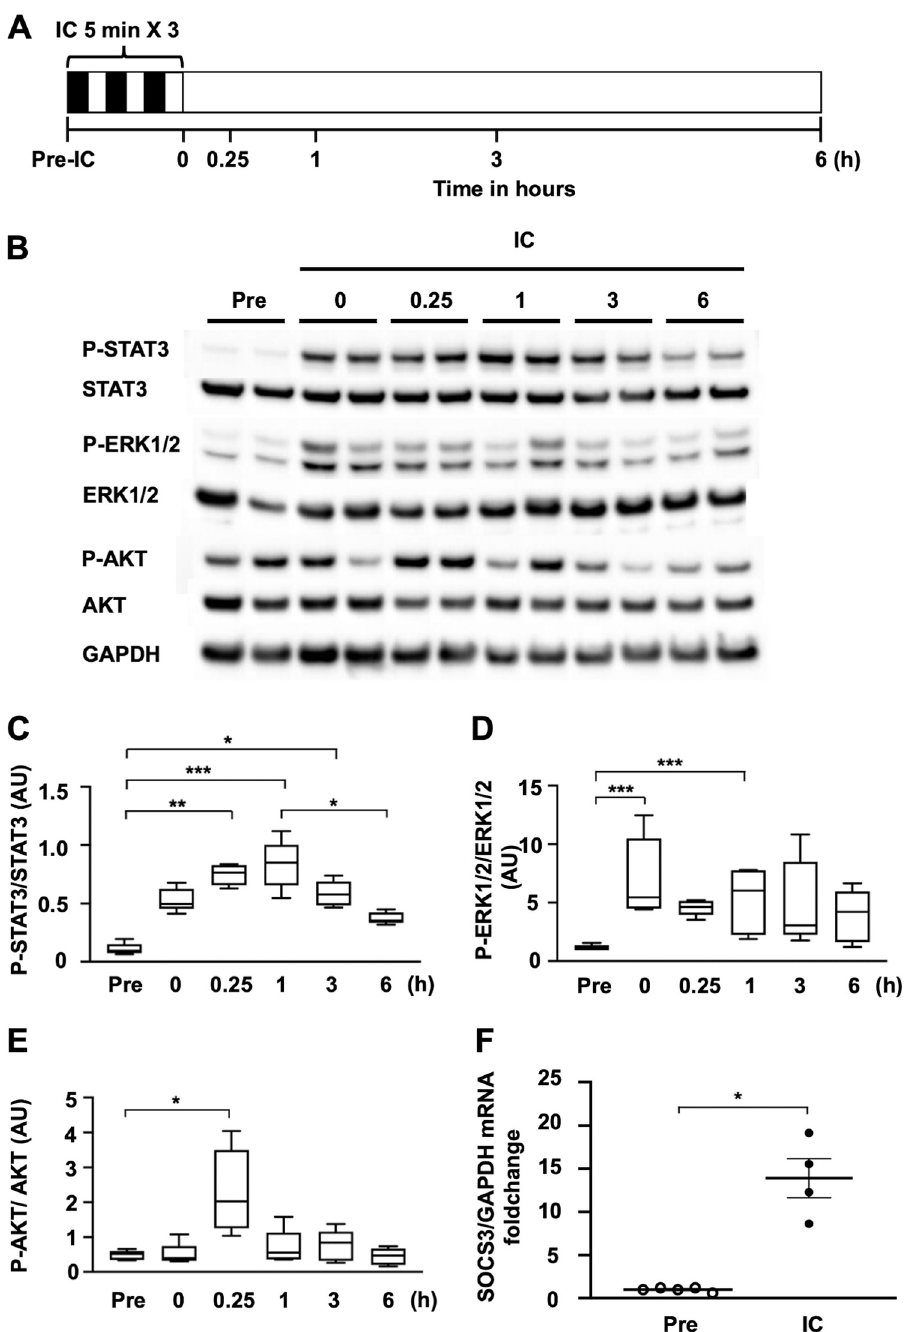
Fig 1. Transient myocardial STAT3 activation and SOCS3 expression in WT mice after ischemic conditioning alone. Western blot analysis of total cell lysates prepared from heart tissue of WT or SOCS3-CKO mice at the indicated time-points after IC. ( A ) Schematic illustration depicting the experimental protocol. ( B) Blots were probed using antibodies against phosphorylated STAT3 (P-STAT3), total STAT3, phosphorylated ERK1/2 (P-ERK1/2), total ERK1/ 2, phosphorylated AKT (P-AKT), total AKT, and GAPDH. ( C) , ( D) , and ( E) Graphs display the quantitative differences in expression between the ratios of P-STAT3 to total STAT3 ( C ), P-ERK1/2 to total ERK1/2 ( D ), and P-AKT to total AKT ( E ) (n = 5 per group). � p < 0.05, ��� p < 0.01 (Dunn’s test). (F) Real-time PCR analysis of SOCS3 mRNA expression in mouse hearts pre-IC or 3 h after IC (n = 4–5 for each group). � p < 0.05 (Wilcoxon rank-sum test). WT, wild-type; IC, ischemic conditioning; AU, arbitrary units; GAPDH, glyceraldehyde 3-phosphate dehydrogenase.